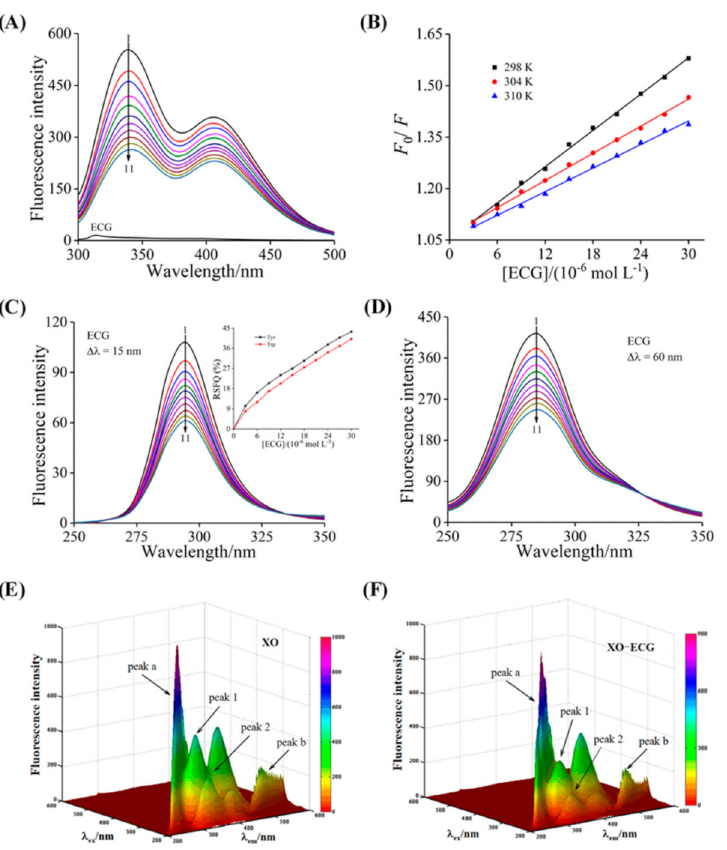
Figure 3. Fluorescence measurements. ( A ) Effects of ECG on the fluorescence emission spectra of XO: c (XO) = 1.0 µ M, c (ECG) = 0, 3.0, 6.0, 9.0, 12.0, 15.0, 18.0, 21.0, 24.0, 27.0, and 30.0 µ M for Curves 1 → 11, respectively; ( B ) the Stern–Volmer plots at 25, 31 and 37 ◦ C. Synchronous fluorescence spectra of XO in the presence of different concentrations of ECG at the ∆ λ of 15 nm ( C ) and 60 nm ( D ): c (XO) = 1.0 µ M, c (ECG) = 0, 3.0, 6.0, 9.0, 12.0, 15.0, 18.0, 21.0, 24.0, 27.0, and 30.0 µ M for Curves 1 → 11, respectively. The insert was RSFQ values of Tyr and Trp. 3D fluorescence spectra of free XO ( E ) and ECG–XO system ( F ): c (XO) = 1.0 µ M, c (ECG) = 15.0 µ M. Table 1. The values of quenching constant ( K sv ), binding constant ( K a ), number of binding sites ( n ) and thermodynamic parameters of the interaction between ECG and XO at 25, 31, and 37 ◦ C. T